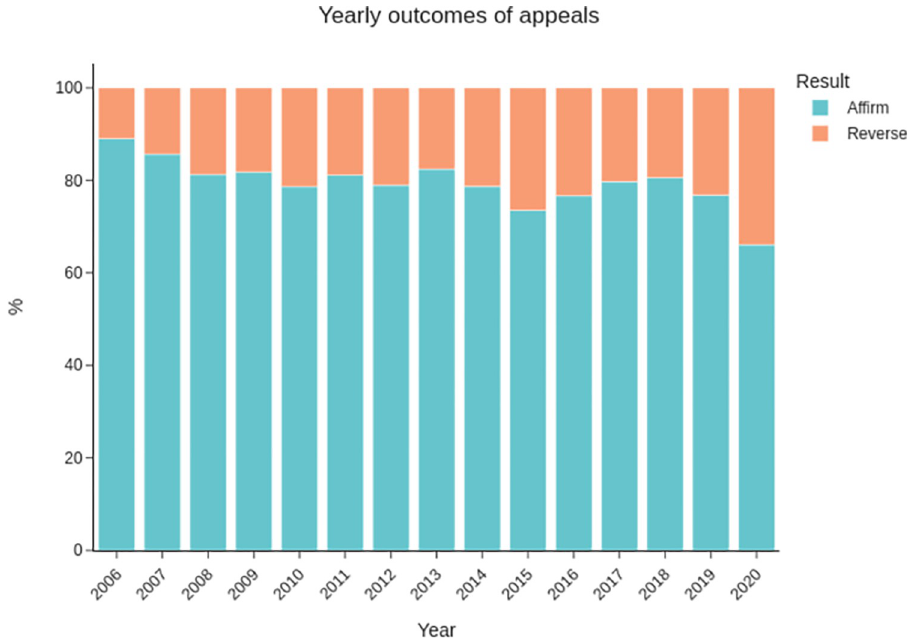
Fig 1. Yearly distributions of results of appeals against rulings from Federal Small Claims Courts within the jurisdiction of the 5th Regional Federal Court. The data for 2020 contains appeals tried during the first trimester.